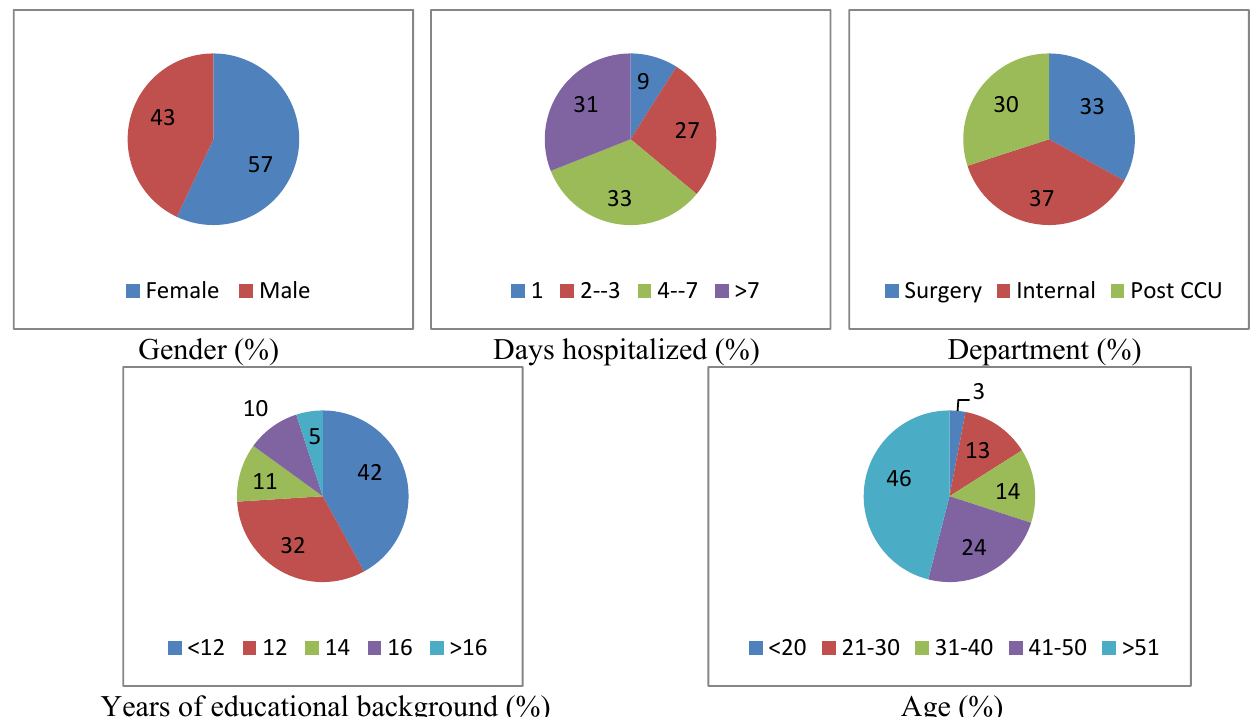
Fig. 2. Personal characteristics of the participants